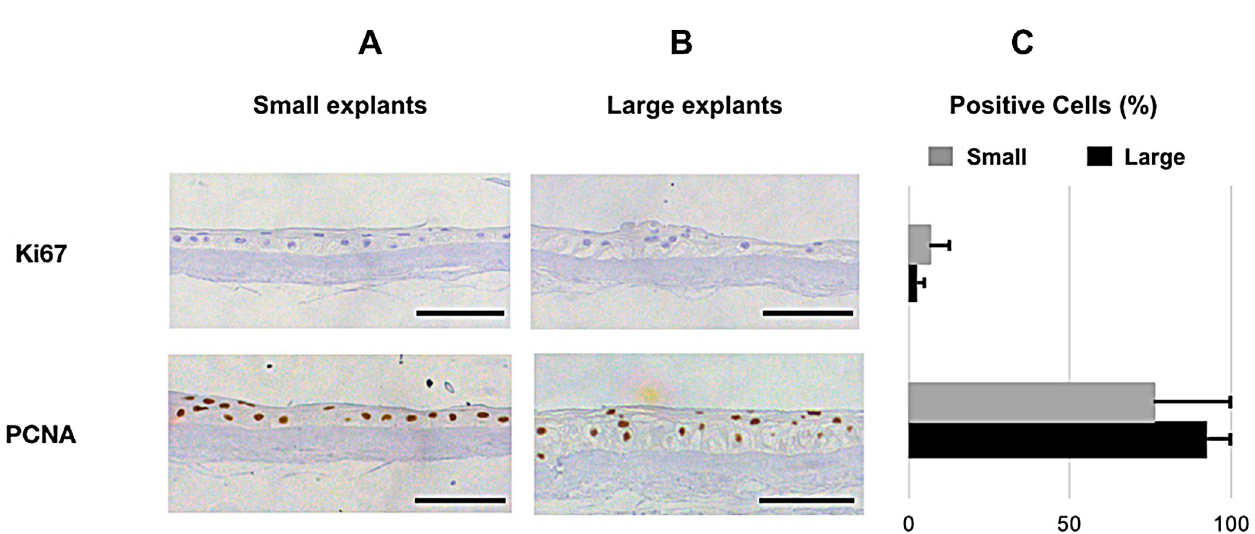
Fig 9. Immunostaining (A and B) and Quantification (C) of proliferation markers. A, and B: Immunostaining of 1) Ki67, and 2) PCNA of cultured human LEC derived from small (A) and large (B) limbal explants. The selected areas in the micrographs are representative for the staining and not for the epithelial thickness in the study groups. Scale bar = 100 μ m. C: Bar charts showing the percentage of positive cells for the proliferation markers in cultured LEC sheets cells derived from small (grey) and large (black) explants. Error bars represent the standard deviation of mean values.